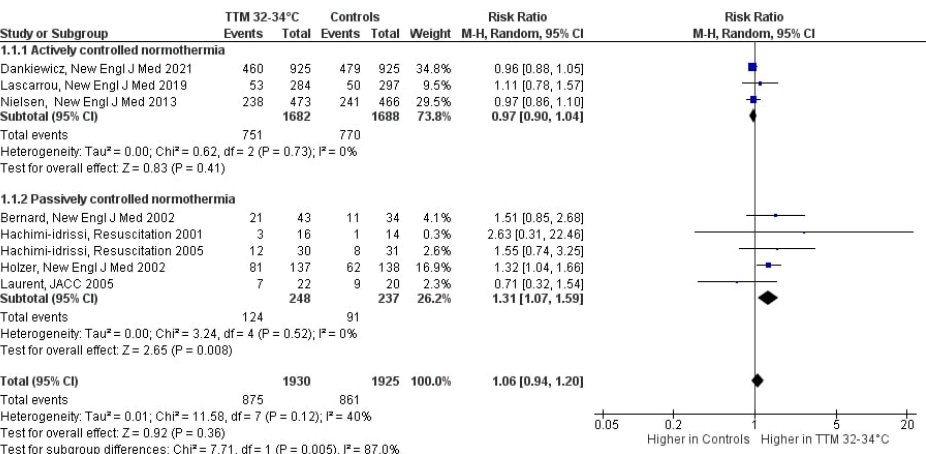
Figure 2. Forest plot of survival in patients resuscitated after cardiac arrest. Com-parison is made between patients according to the strategy of target temperature man-agement (TTM). CI: confidence interval; M-H: